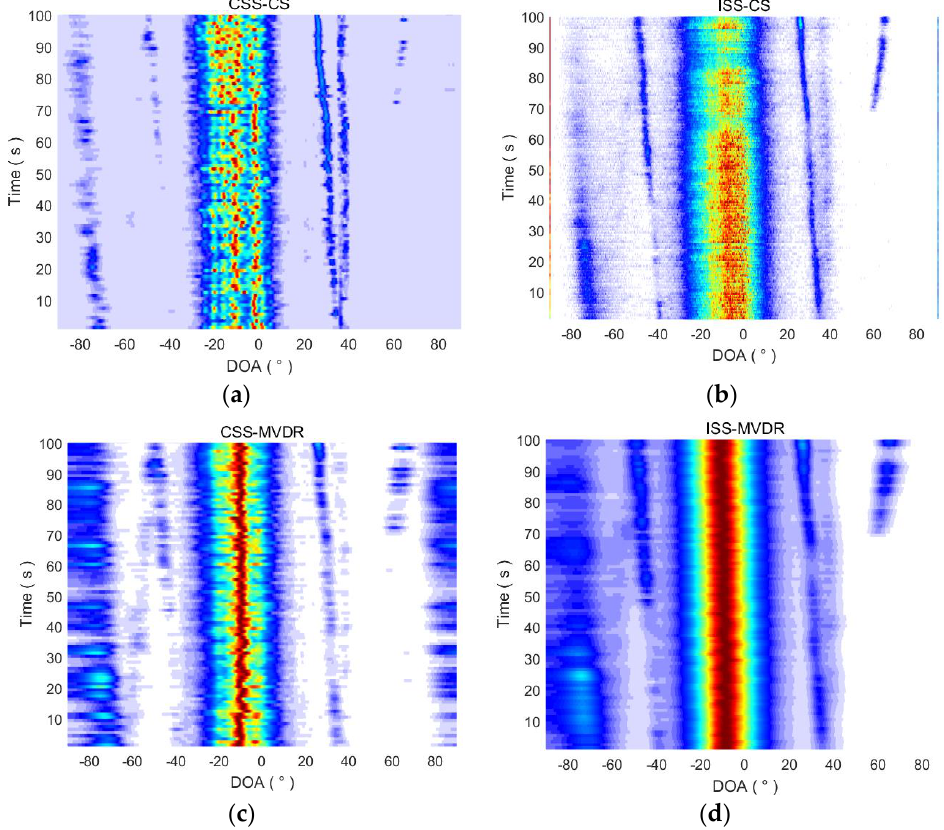
Figure 16. The DOA estimation time tracks of the four methods in the first 100 s. ( a ) The DOA estimation time tracks of CSS-CS in the first 100 s; ( b ) The DOA estimation time tracks of ISS-CS in the first 100 s; ( c ) The DOA estimation time tracks of CSS-MVDR in the first 100 s; ( d ) The DOA estimation time tracks of ISS-MVDR in the first 100 s.